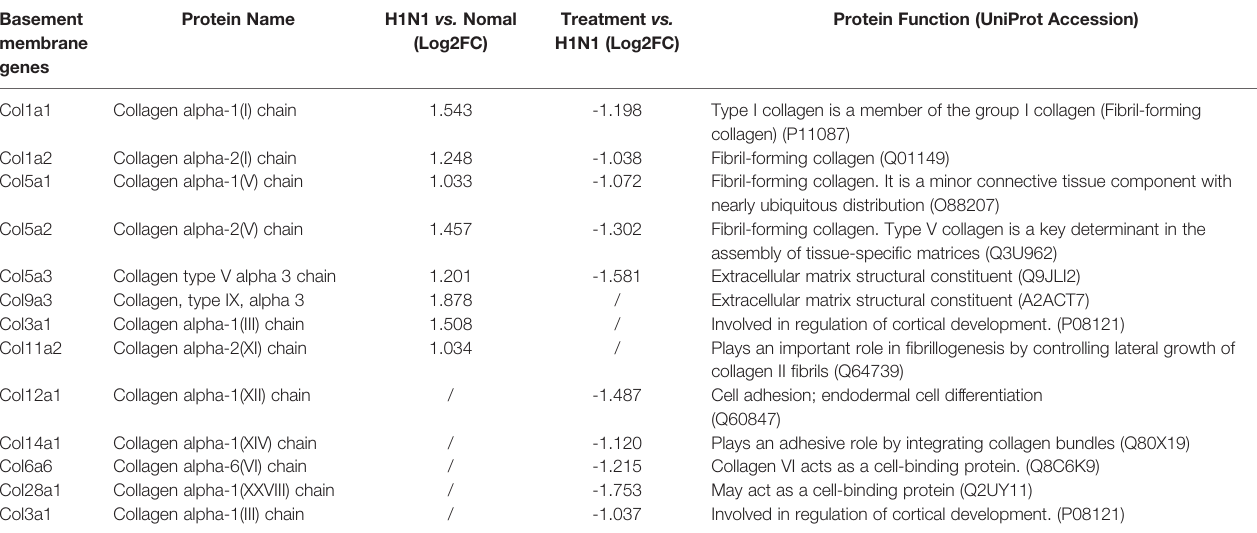
TABLE 2 | Differentially expressed basement membrane